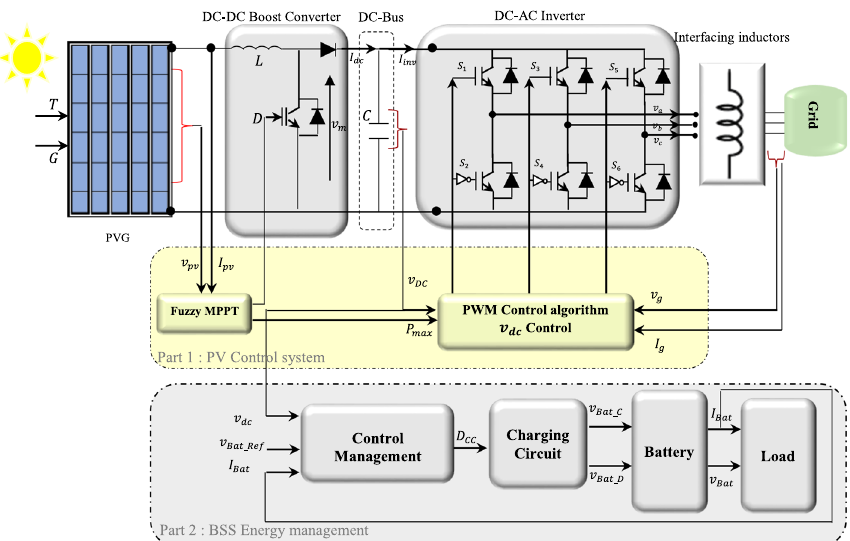
Fig. 1 Structure of proposed